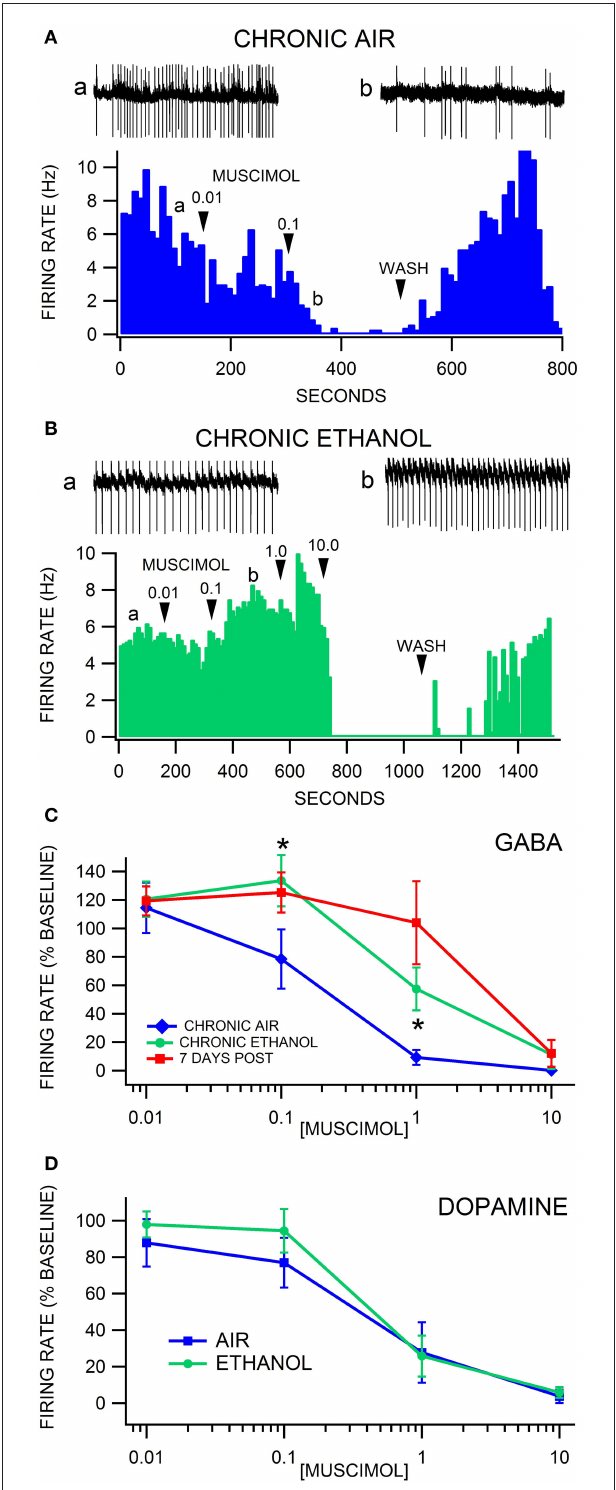
FIGURE 5 | Decreased sensitivity of VTA GABA, but not DA neurons, to muscimol after chronic intermittent ethanol vapor exposure. (A) The ratemeter shows the firing rate of a VTA GABA neuron (traces a, b recorded at times